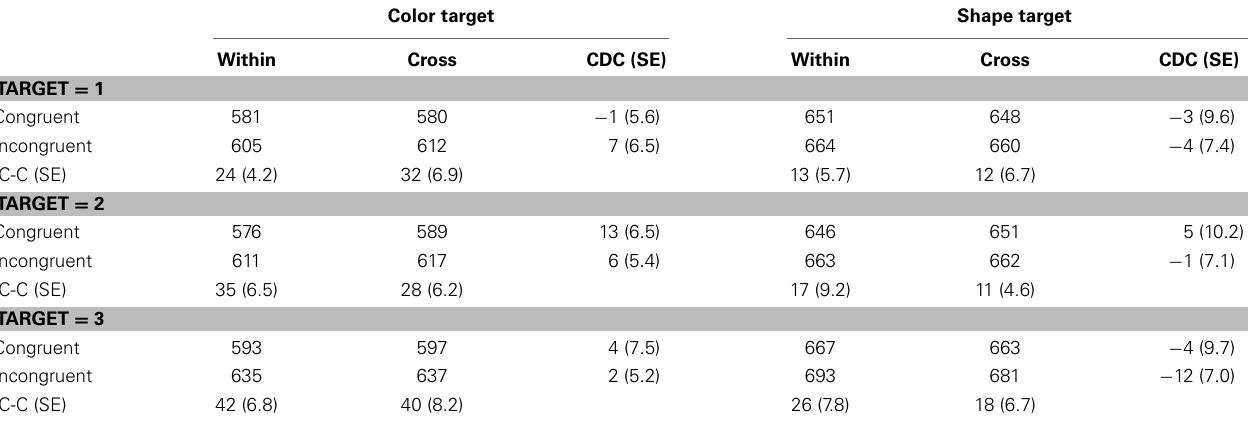
Table 7 | RTs (in milliseconds) and standard errors (SEs, in parentheses) in Experiment